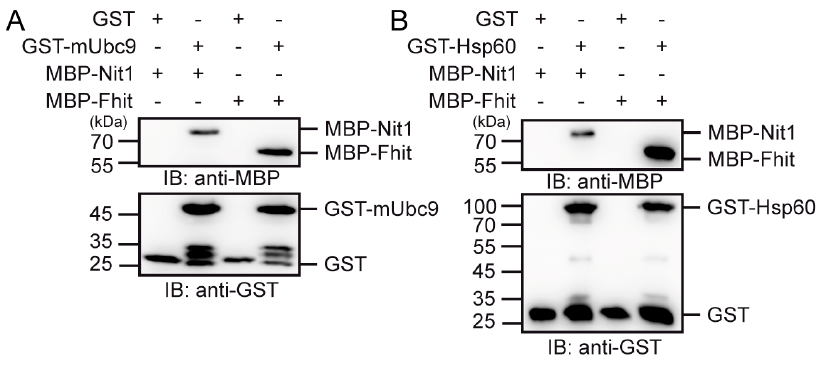
Figure 6. Nit1 binds to known Fhit interaction partners. MBP-Nit1 interacts with GST-mUbc9 ( A ) or GST-Hsp60 ( B ) in pull-down assays. Protein complexes were analyzed by SDS-PAGE and